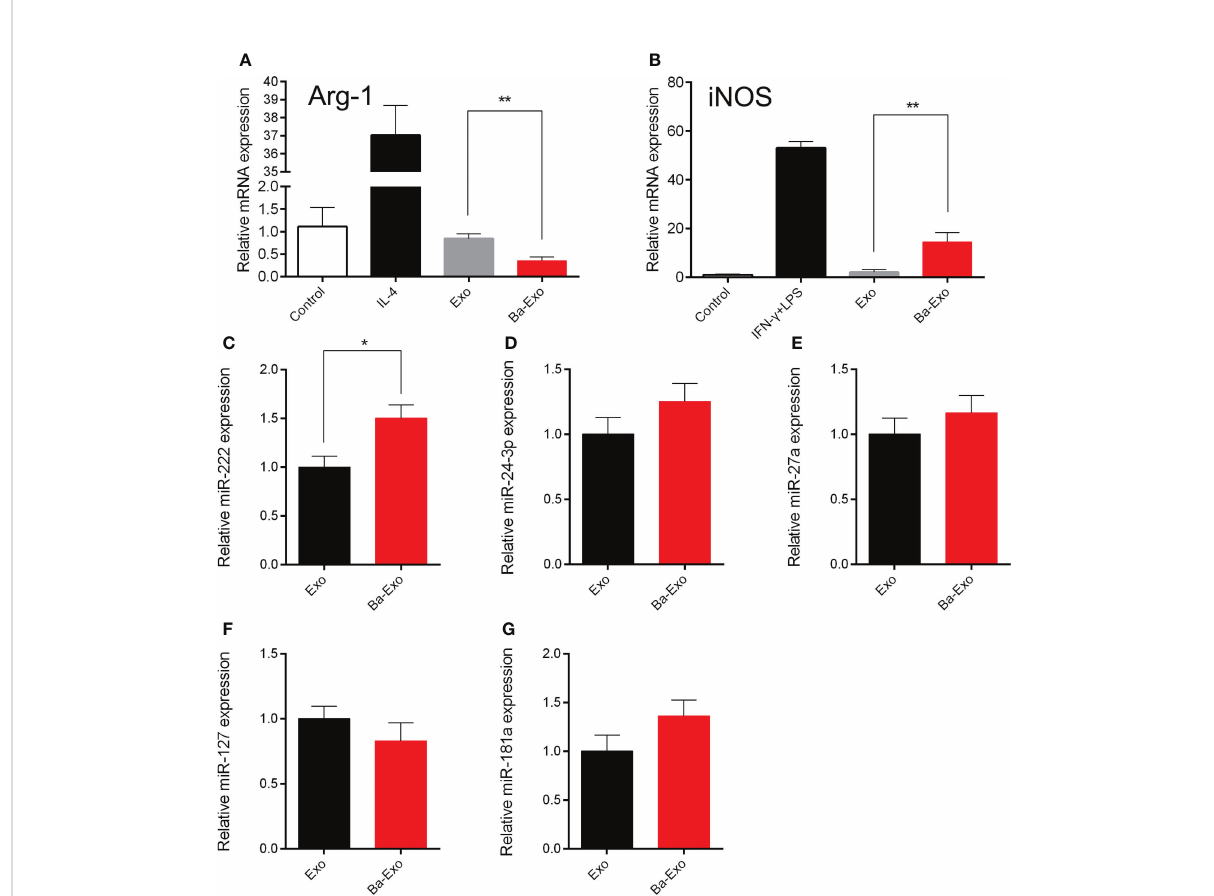
FIGURE 6 Ba-Exo can promote M j polarization to M1. Ba-Exo can decrease the Arg-1 mRNA expression (A) and improve the iNOS mRNA expression (B) . The reactions were run in combination with the endogenous b -actin control. The total RNA was extracted and transcribed from Ba-Exo and Exo group. Validation of miR-222 (C) , miR-24-3p (D) , miR-27a (E) , miR-127 (F) , miR-181a (G) expression in Ba-Exo and Exo by quantitative polymerase chain reaction assay. The relative expression levels were calculated using the 2 - DD CT method with U6 snRNA for normalization. Mean ± SD of three independent experiments are shown. *p < 0.05, **p < 0.01. Arg1, arginase 1; iNOS, inducible nitric oxide synthase; SD, standard